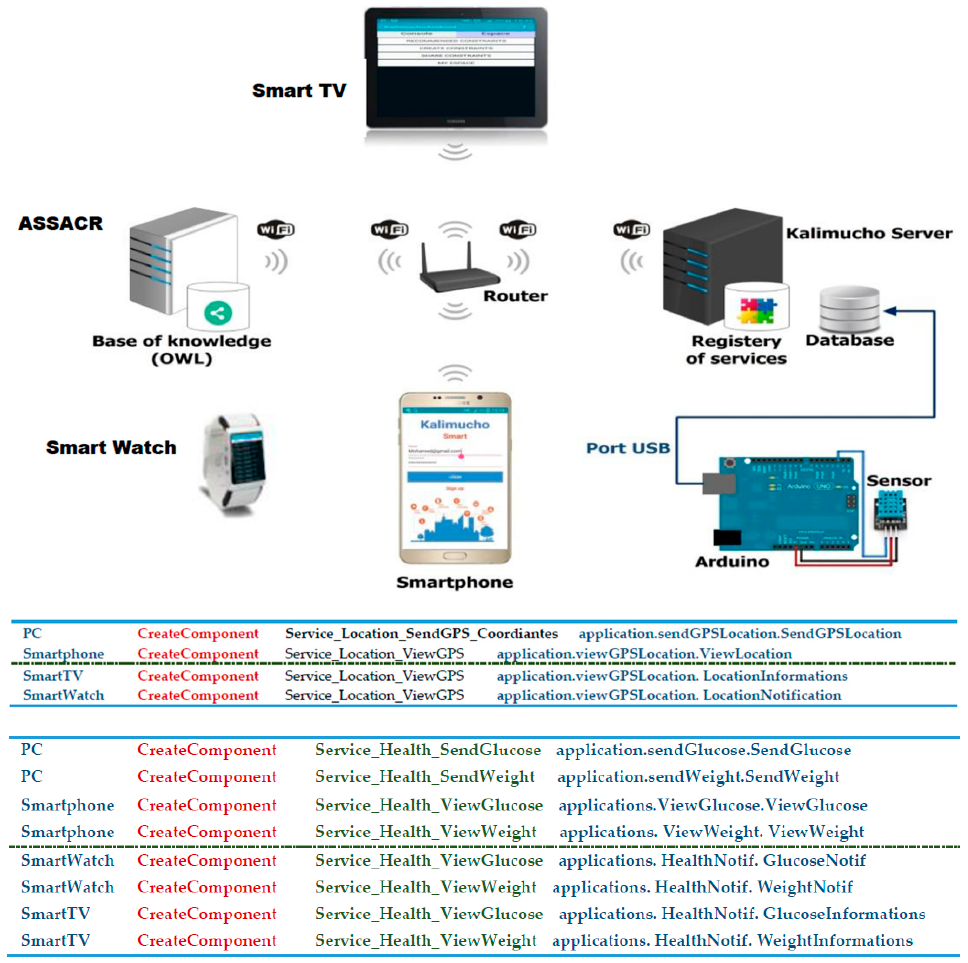
Figure 19. Available devices in a smart home and the initial script generation.